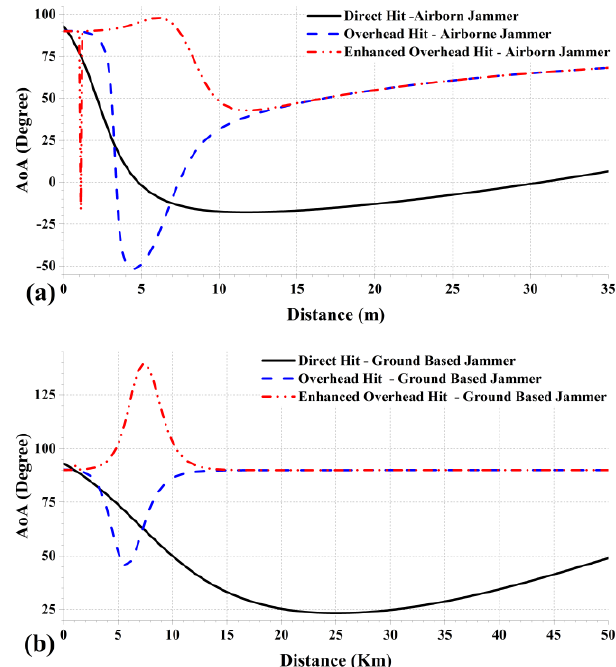
Figure 4. The Angle of Arrival (AoA) of the jamming signal for a) air-born GPS jammer, b) ground-based GPS